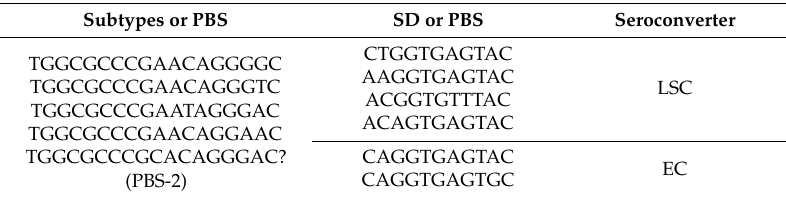
Table 3. Specific subtype, PBS, and SD variant combinations in late or early seroconverters. Subtypes or PBS